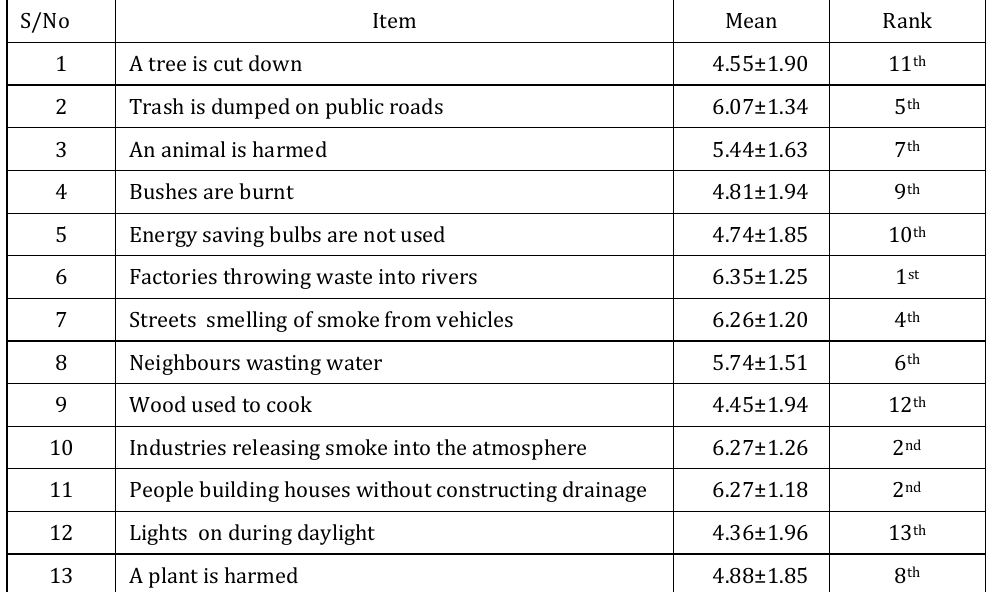
Table 2. Descriptive analysis of items in the scale of attitude towards environmental abuse Item